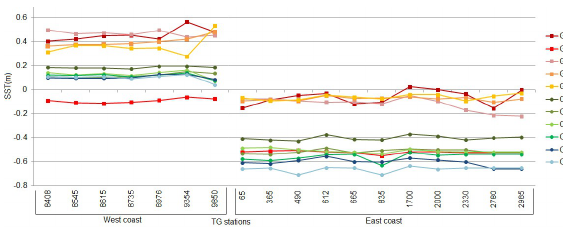
Figure 3. Estimated SST from various models at 27 TG stations in Canada.